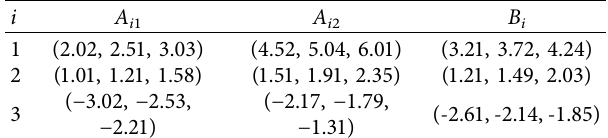
Figure 3: The established coordinate system of the equipment arrangement. Table 1: The fuzzy sets in the initialized rule